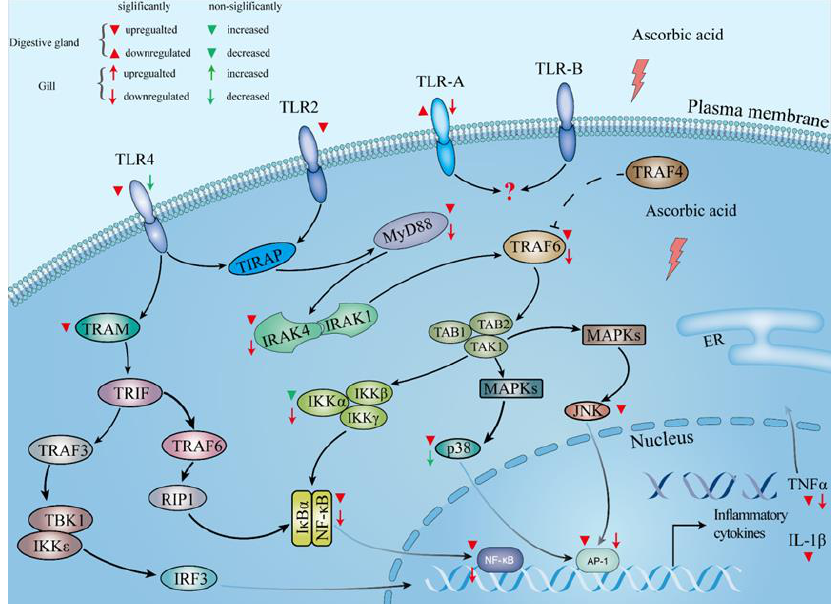
Figure 7. The potential TLR signaling pathway in the digestive gland and gill of abalone ( Haliotis discus hannai ) after a 100-day feeding trial. The upregulated and downregulated genes are marked by flammulated up-triangle (digestive gland) or up-arrow (gill), and down-triangle (digestive gland) or down-arrow (gill), respectively. The green up-triangle (digestive gland) or up-arrow (gill) and down-triangle (digestive gland) or down-arrow (gill) indicate the increasing and decreasing trend of the genes, but their expression levels were not significant. The signaling pathway of TLR-A and TLR-B is unclear in the recent study and marked by “?”.